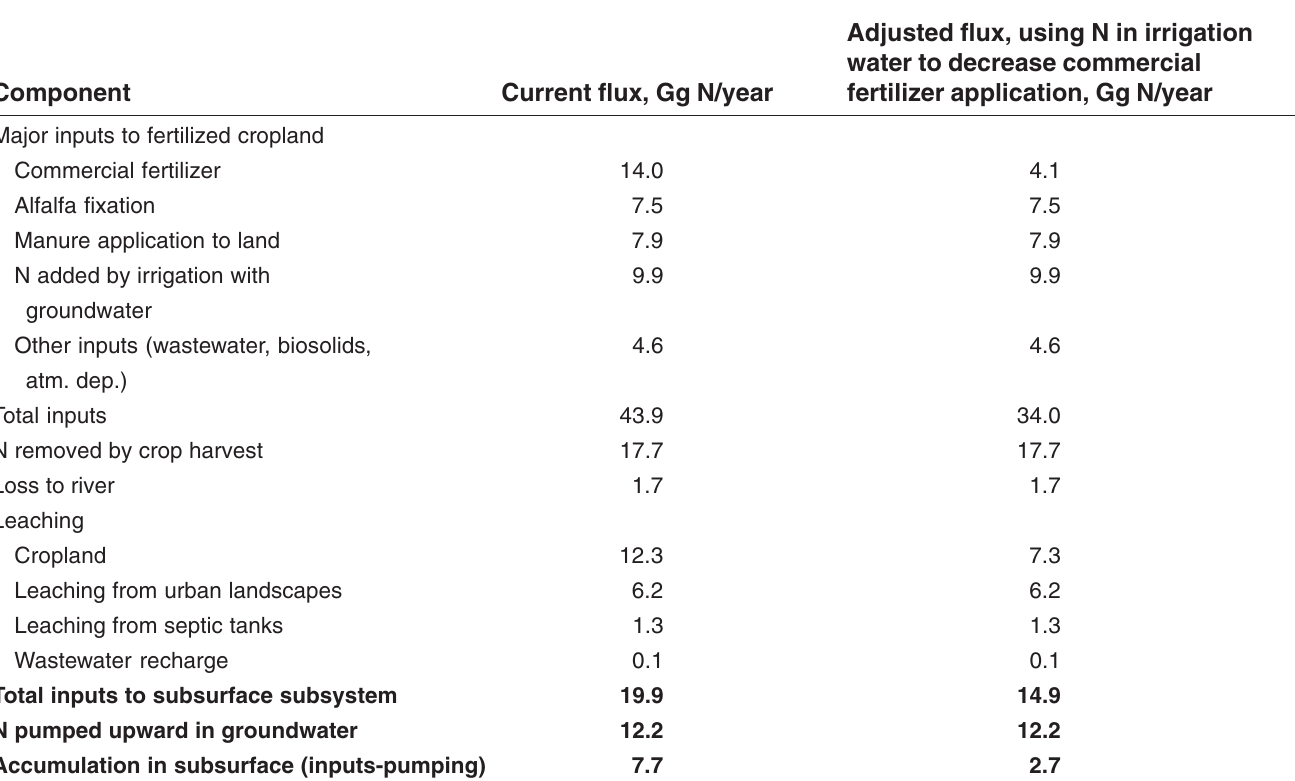
Nitrogen Balance for the Subsurface Subsystem of the CAP Ecosystem* Adjusted flux, using N in